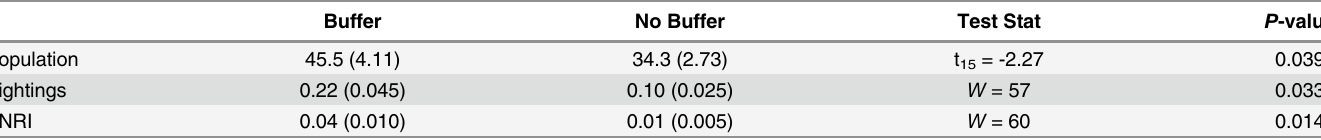
Table 5. Comparisons of the annual probability of wolf sighting, wolf population, and Pack Near Road Index (PNRI) for years following the pres- ence (2001 – 2010) and absence (1997 – 2000, 2011 – 2013) of a hunting and trapping buffer adjacent to Denali National Park and Preserve, AK, USA. Table entries are the mean values (SE), test statistics ( t for t-test and W for Mann-Whitney-Wilcoxon test), and associated probability for each